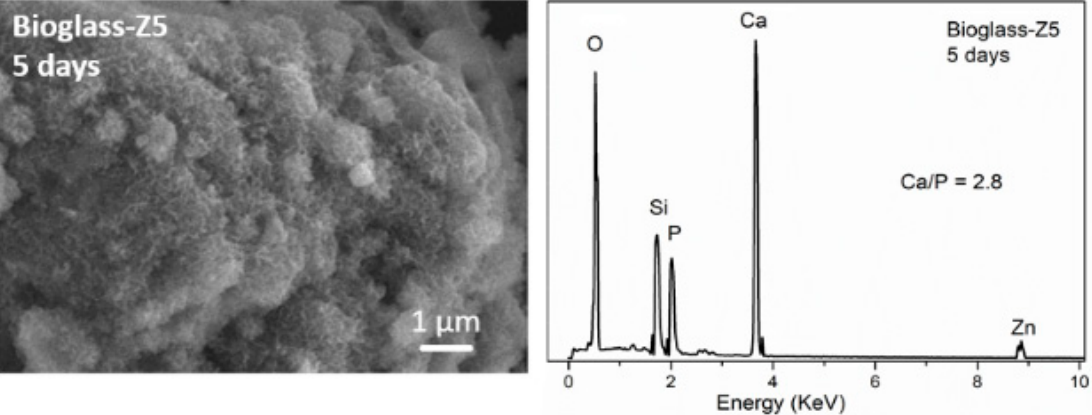
Figure 5. SEM–EDX analyses of bioactive glasses 70SiO 2 –(30-x)CaO–xZnO (mol.%, x = 1, 3, 5) after 5 days in simulated body fluid (SBF)